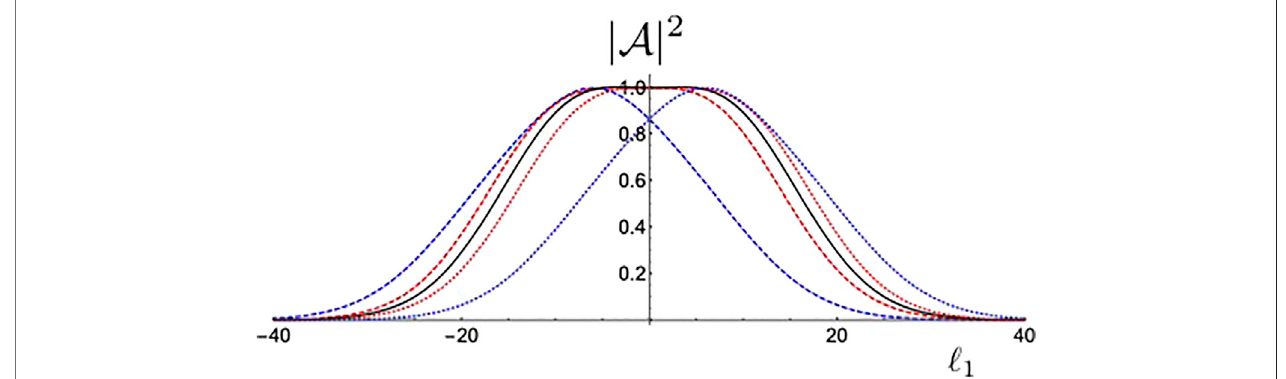
FIGURE5 |(A) Normalized probabilities for an optimal PV pump beam with ℓ (cid:1) 0 (redsolidline) and a gaussian pump beam with w p (cid:1) 5 w 0 (black dashed line). The PV pump mode concentrates the probability in lower OAM modes. (B) The Schmidt number K for the two photon state, truncated at ± ℓ max for the same pump beams. The grey dotted line corresponds to the maximum allowable Schmidt number, given by d (cid:1) 2 ℓ max + 1.